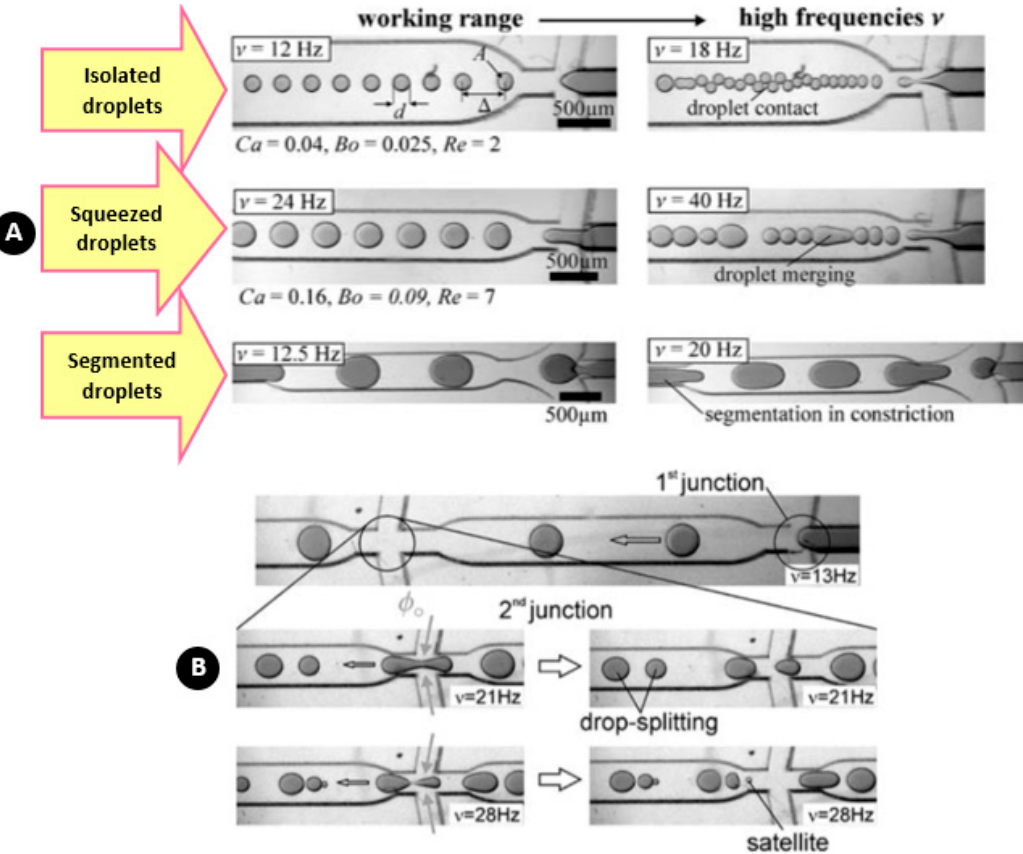
Figure 14. ( A ) Identification of three droplet structures depending on the channel geometry and rotational frequency; ( B ) Droplet splitting at the downstream in di ff erent frequencies. Reprinted with rotational frequency; ( B ) Droplet splitting at the downstream in different frequencies. Reprinted with permission from permission from [46].